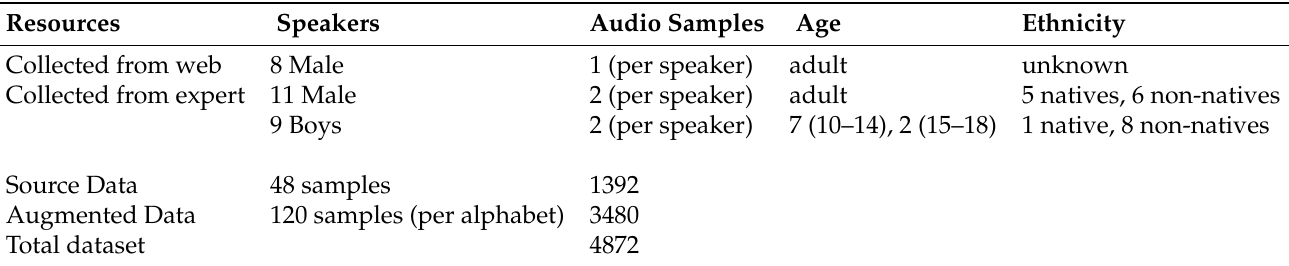
Table 2. Dataset of alphabet